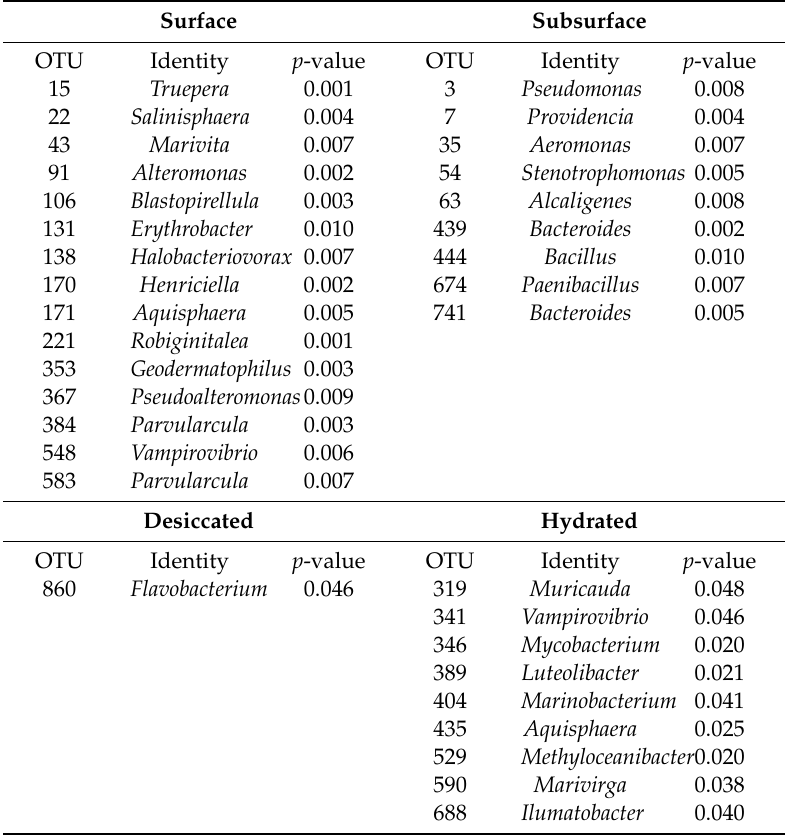
Table 2. Bacterial taxa that were significantly more abundant in 16S rRNA sequence data from saltpan wetland sediments in either a desiccated or hydrated state, or in the surface or 30 cm deep subsurface. Community composition di ff ered significantly by depth but not hydration, so α = 0.01 was used for summarizing di ff erences by depth and α = 0.05 for summarizing di ff erences by hydration state. Only those OTUs which had a significant p -value and were identified at the genus level are